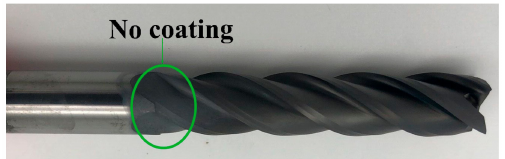
Figure 1. The non-uniform diamond coatings on the cutting tools with a long-flute, deposited by hot filament chemical vapor deposition (HFCVD) with the copper